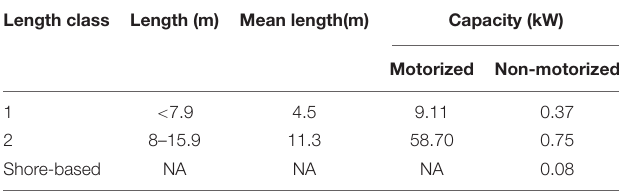
TABLE 1 | Assumed and derived engine capacity of motorized and non-motorized fishing vessels by length class for small-scale vessels based on Greer et al. (2019a), as well as engine capacity-equivalency for shore-based fishers. Length class Length (m) Mean